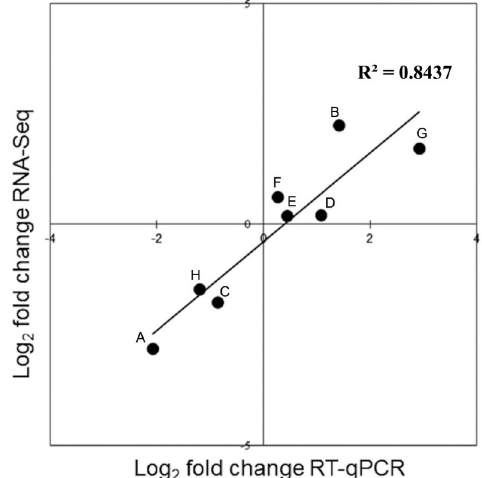
Figure 6. Validation of differentially expressed novel and known miRNAs using RT-qPCR. RNA at each time point was isolated from five biological replicates and mixed in an equivalent proportion for RT-qPCR analysis. Letters A to H represent the miRNA samples novel-mir23, novel-mir162, novel-mir214, novel- mir225, bra-miR5726, bra-miR160a-3p, bra-miR164e-5p, and bra-miR156e-3p,